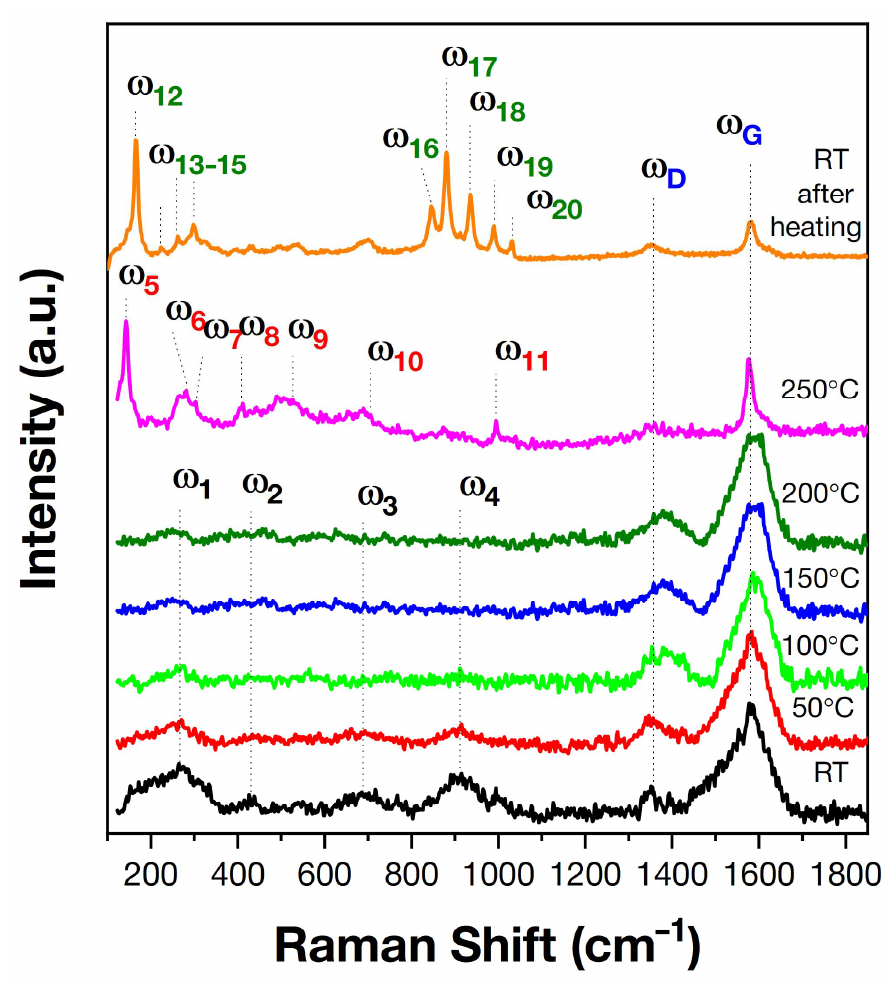
Figure 5. In situ Raman spectra during heating of V 2 CT x MXene film in air in the temperature range RT–250 °C.